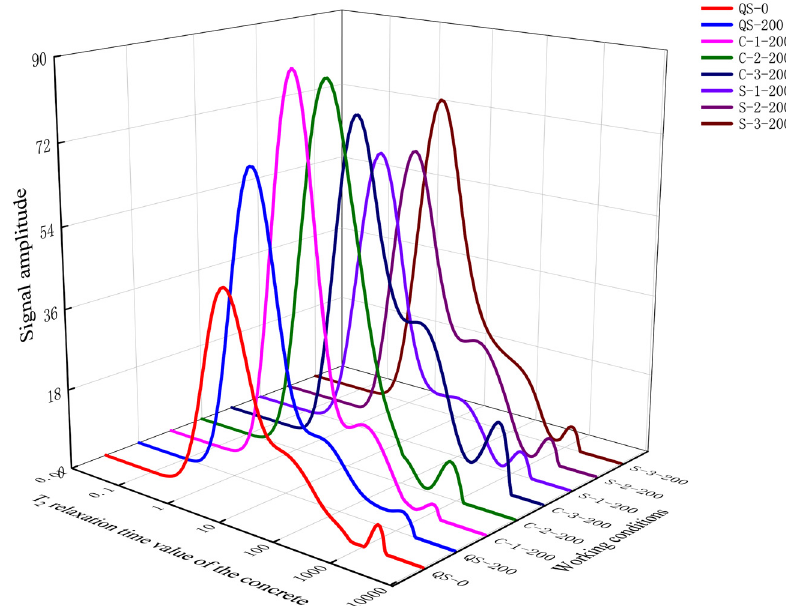
Figure 7: Nuclear magnetic resonance T 2